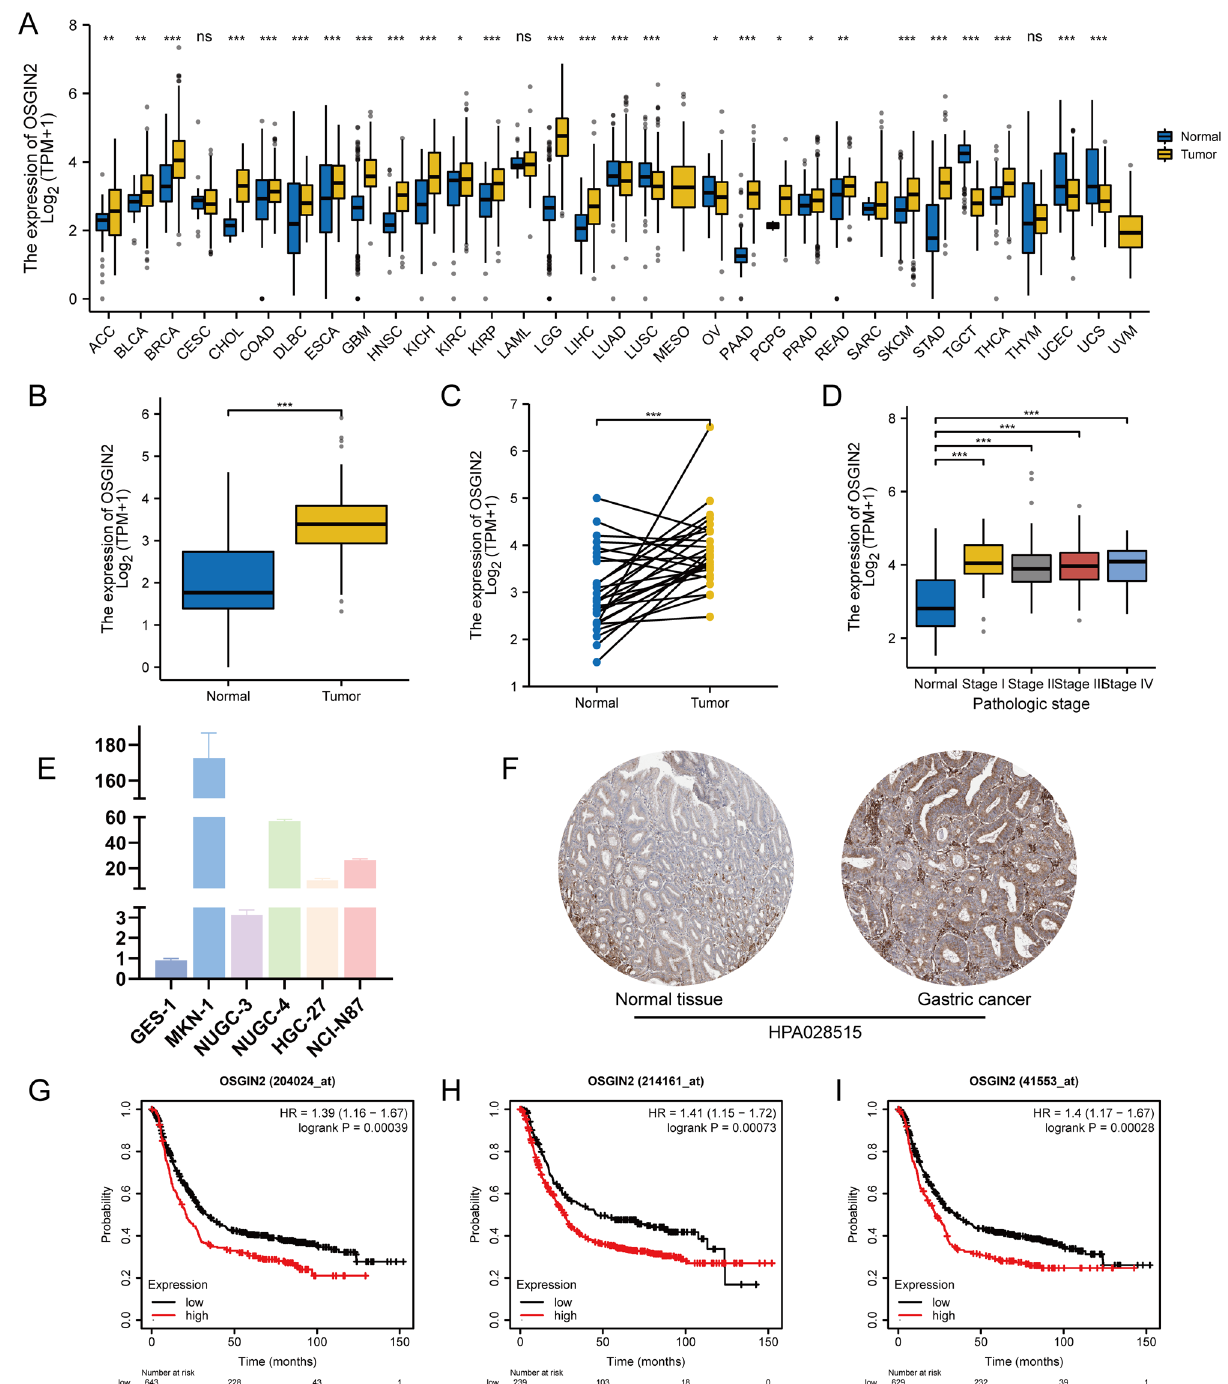
Figure 2. OSGIN2 is highly expressed in gastric cancer and indicates poor prognosis ( A ) Differential expression of OSGIN2 in TCGA pan-cancer. The results show increased expression of OSGIN2 in various tumor tissues. ( B , C ) Differences in the expression of OSGIN2 in TCGA-STAD. The results suggest higher expression of OSGIN2 in gastric cancer than in normal tissues. ( D ) The expression of OSGIN2 is higher in gastric cancer TNM stage I-IV than normal tissue. ( E ) RT-qPCR detection of differences in OSGIN2 expression in various cells. ( F ) The differences in the expression of OSGIN2 in different tissues were obtained from the tissue immunohistochemical results of the HPA public database, which shows high expression of OSGIN2 in gastric cancer tissues compared with normal tissues. ( G – I ) Prognostic analysis of OSGIN2 by KM database shows that high expression of OSGIN2 in three different gastric cancer microarray data indicates poor prognosis. ns p ≥ 0.05; * p < 0.05; ** p < 0.01; *** p <